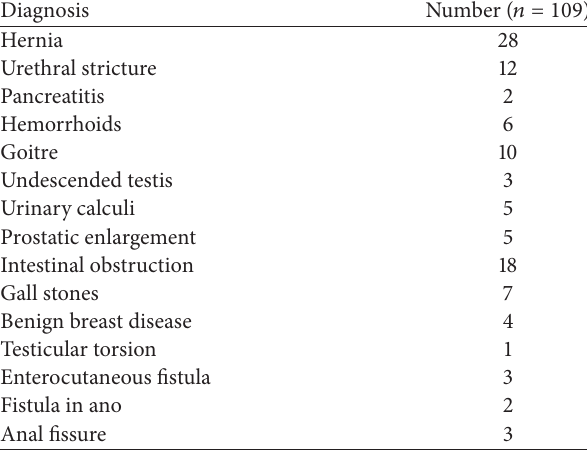
Table 4: Anatomical defect/inflammation.